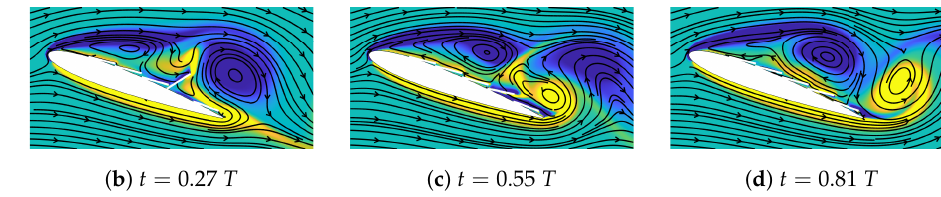
Figure 9. Vorticity contours at different time instants in one period of lift cycle for the case of k β = 0.005 and i β = 10 − 5 .